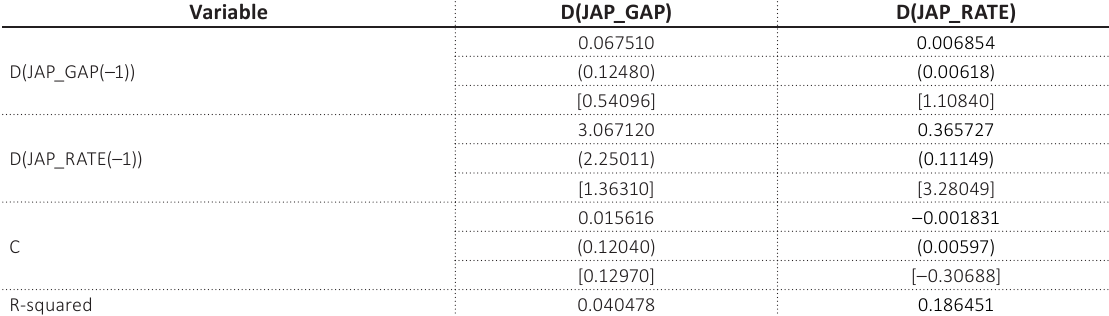
Table A4.2. VAR model assessed for Japan